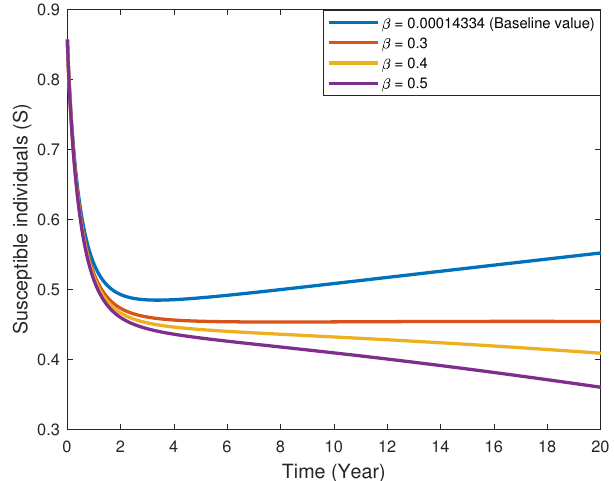
Figure 9. Behavior of S class for different β